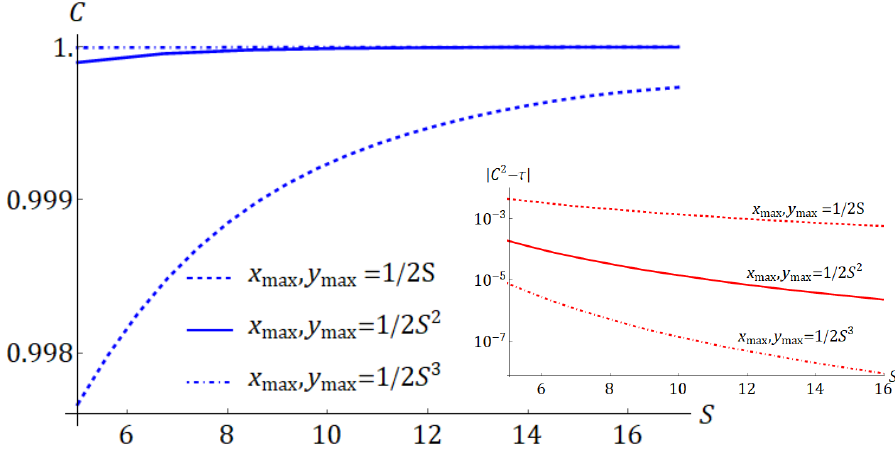
− τ | as a function of S . Each line correspond Q 1 Q 1 Q 2